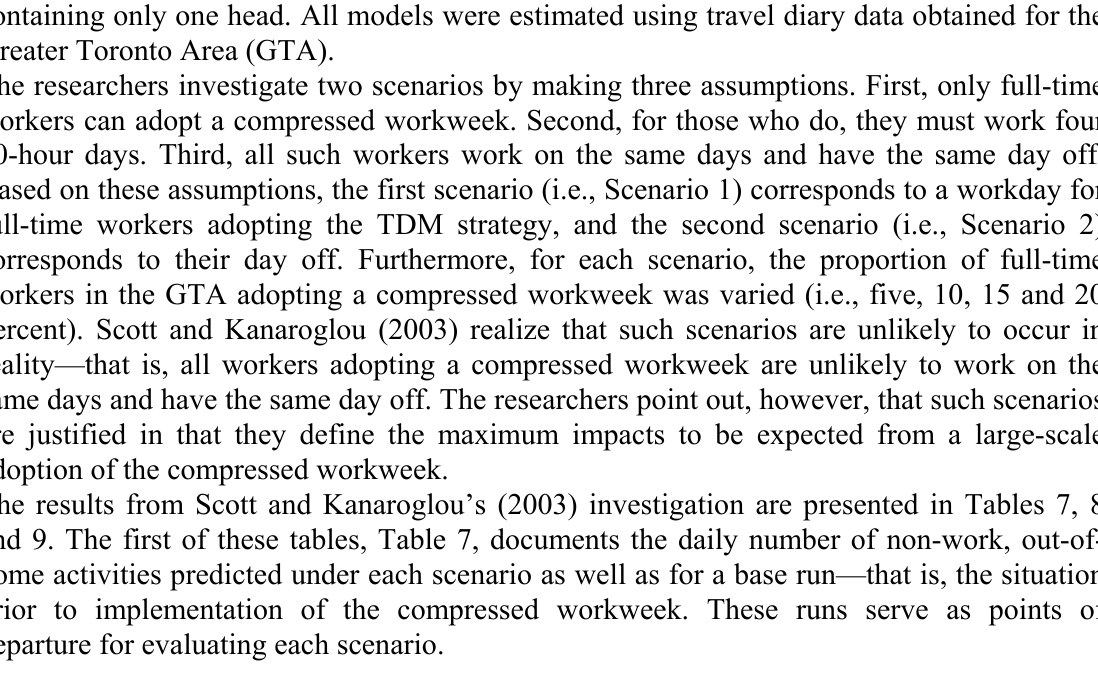
Table 7. Daily number of non-work, out-of-home activities estimated for the heads of households in the GTA, 1986 (Scott and Kanaroglou